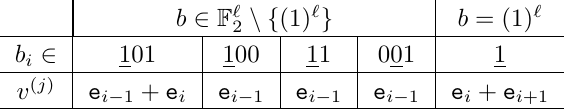
Table 6: The values of basis vectors v ( j ) for b i